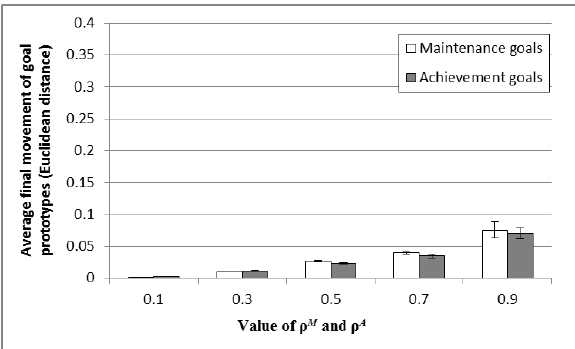
Figure 9: Expt 1: Impact of ρ M and ρ A on stability of cluster proto- types.